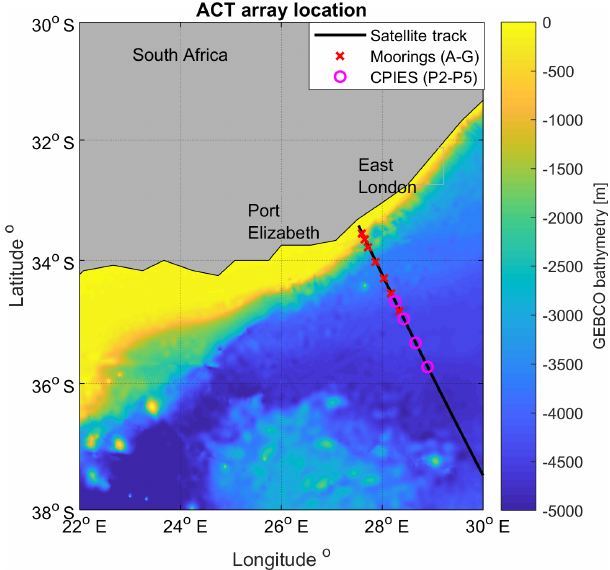
Figure 1. Geographical location of the ACT array with the moor- ing (red crosses) and CPIES (magenta circles) stations relative to the T/P, Jason-1,2,3 satellite track #96 (black line). Colour shad- ing illustrates bathymetry (metres) obtained from GEBCO (General Bathymetric Chart of the